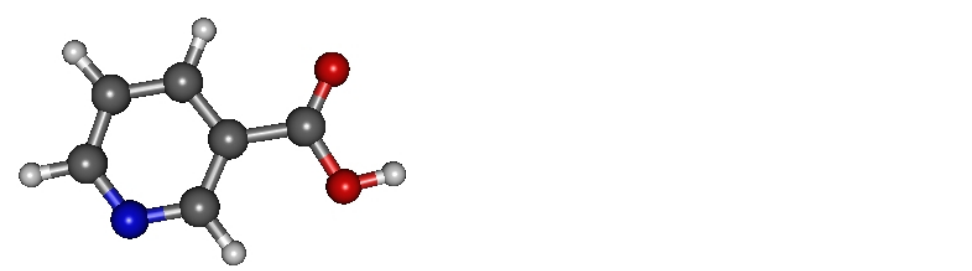
Figure 2. Optimized geometry of vitamin B3 (C 6 H 5 NO 2 ). Figure generated using GABEDIT